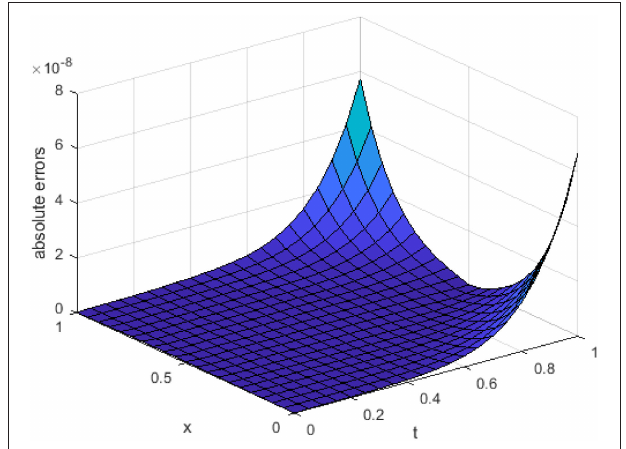
FIGURE 8 | Absolute errors at n = 7 and γ = 2.